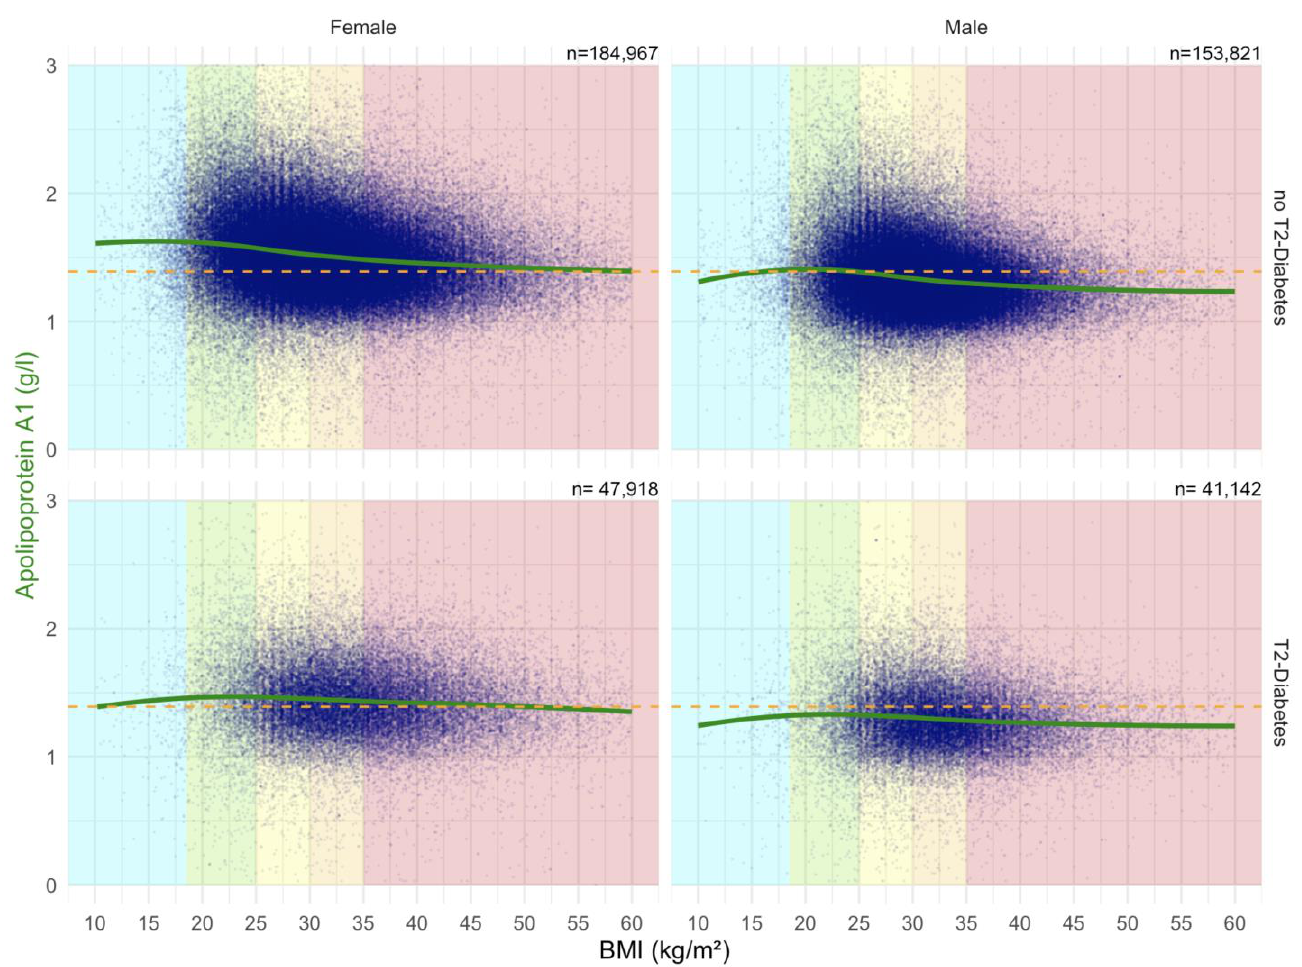
Figure 9. Impact of BMI on the ApoA1 concentrations in “NAFD–Serum” cohort. Median value is the horizontal orange–dashed line. Five vertical zones mark the 5 BMI groups (WHO definition cut-offs: 18.5, 25, 30, 35 and above 40 kg/m 2 ). Each blue point is a protein patient value with its BMI. The green curve is a Loess regression of the median of ApoA1 values. Impact of BMI on Haptoglobin Serum Level in the “NAFLD-Serum” Cohort There was a strong positive correlation between Haptoglobin serum level and BMI, particularly in females (Figure 10).